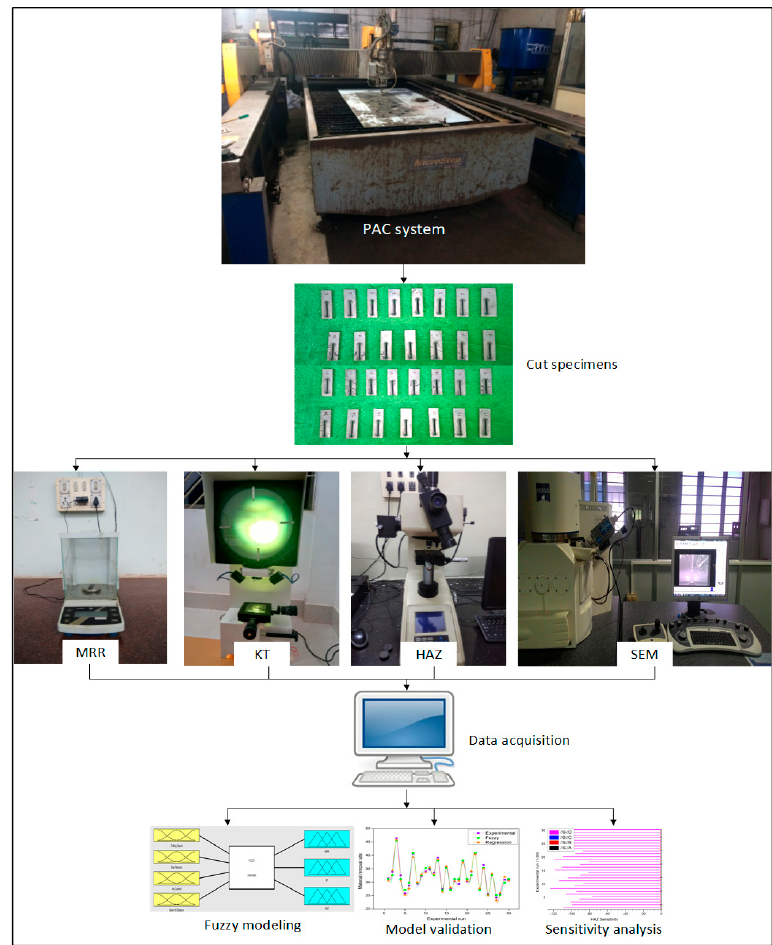
Figure 2. Methodology of the proposed plasma arc cutting (PAC) process.